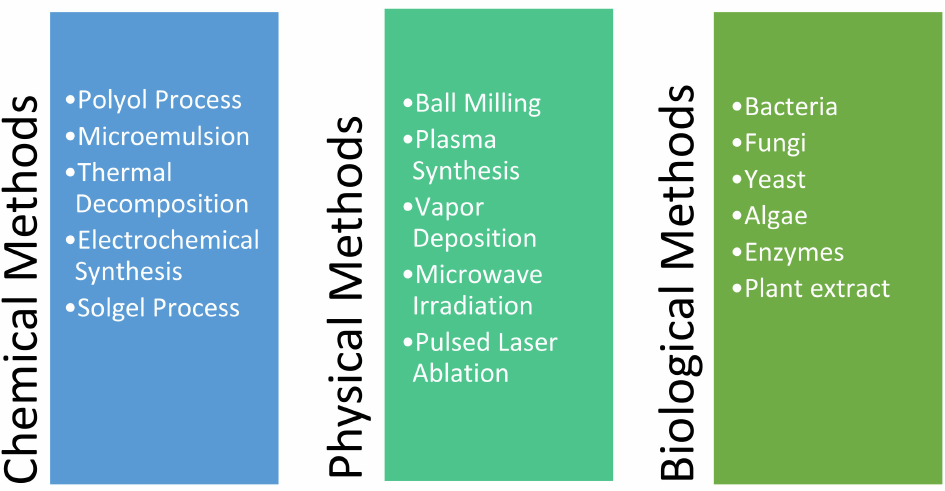
Figure 1. Different methods found in the literature for synthesising metal